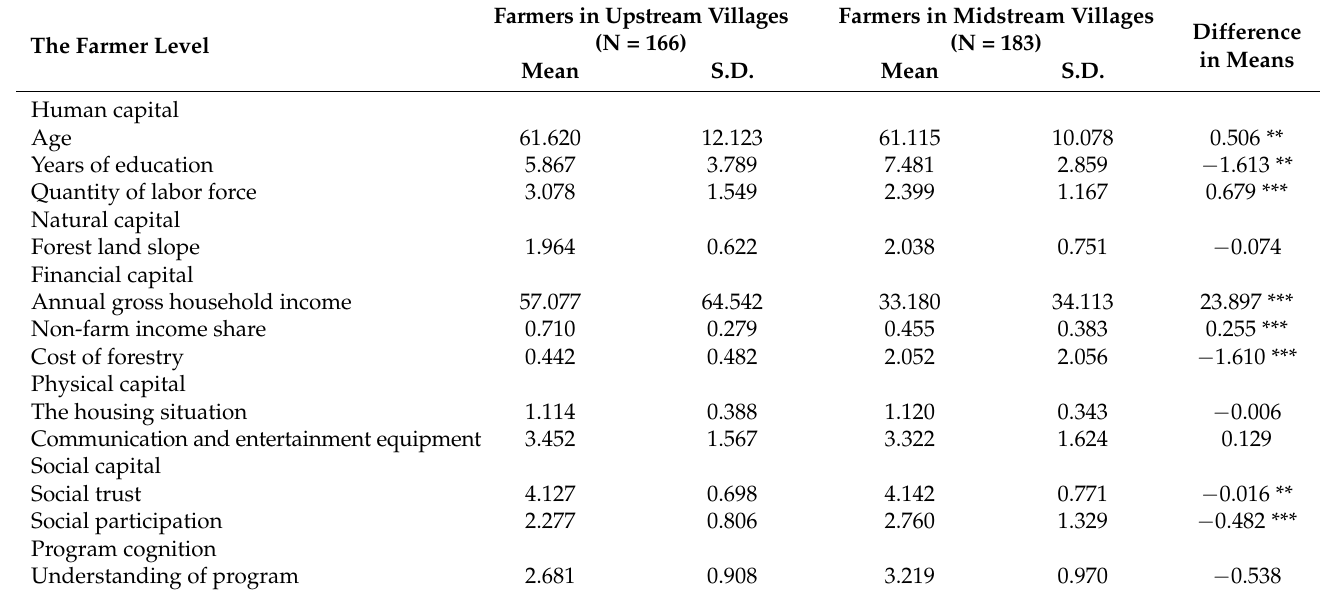
Table 2. Individual characteristics of farmers in upstream and midstream